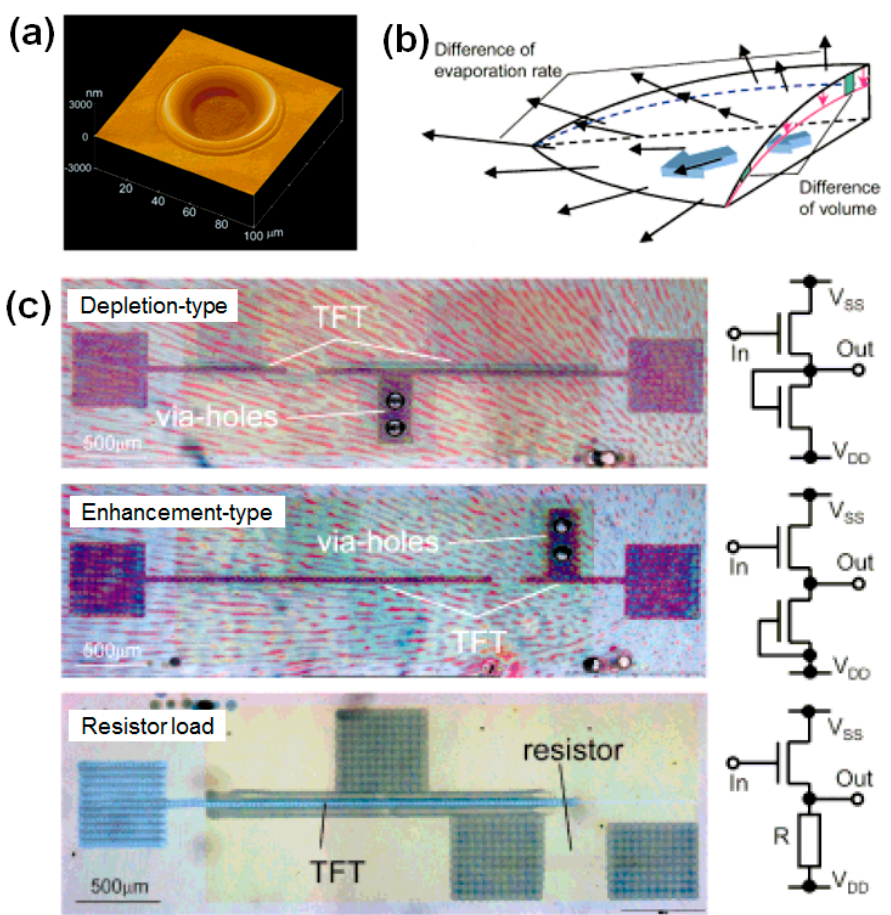
Figure 8. ( a ) AFM image of an inkjet-etched PVP microhole. ( b ) Schematic diagram of the flows in a drying droplet. ( c ) Photographs of three types of inverters (depletion-type, enhancement-type, and resistor load) with poly(3,4-ethylenedioxythiophene) (PEDOT) electrodes connected by via holes in PVP films. The insets on the right show the circuit diagrams of the three types of inverters [11]. Copyright 2001 Wiley.